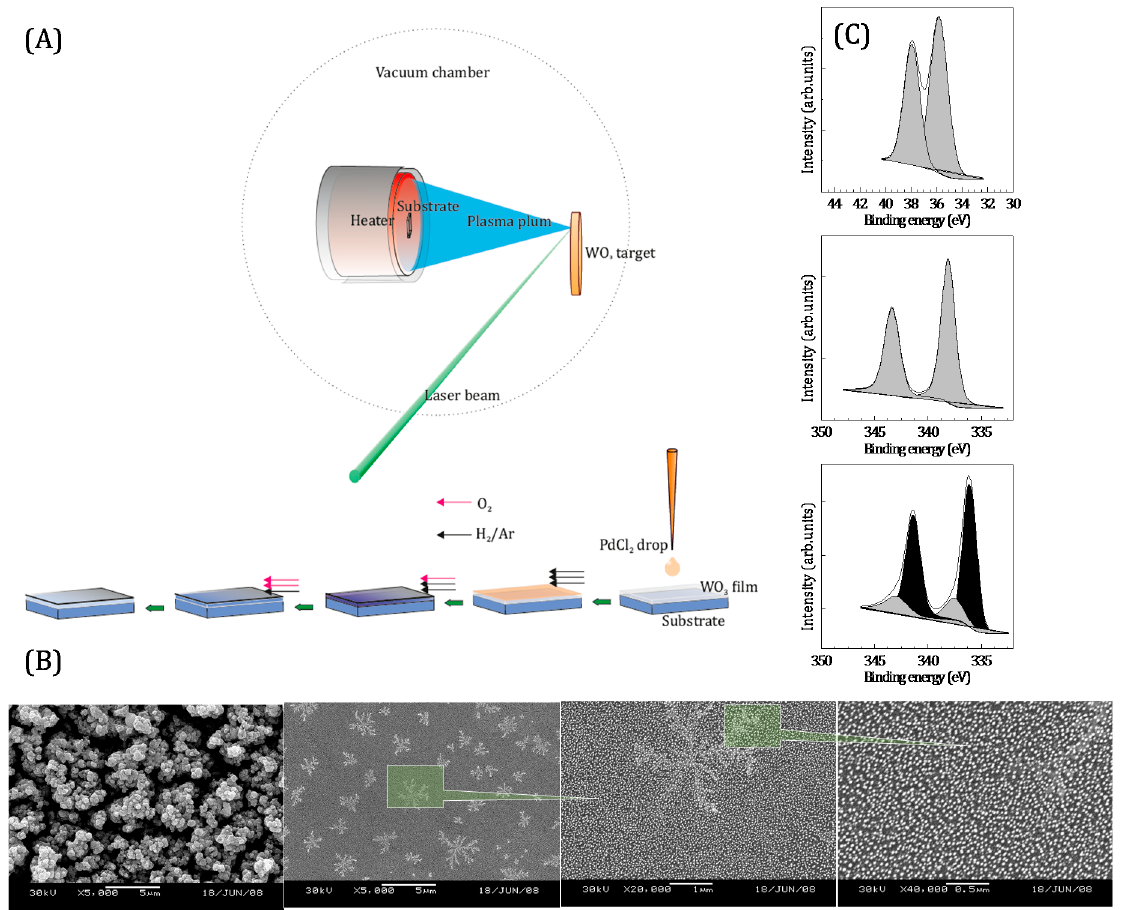
Figure 1. ( A ) Schematic representation of preparation Pd/WO 3 samples, coloration by diluted hydrogen gas and revers steps by adding oxygen flow to examine detection of oxyhydrogen gas. ( B ) typical FESEM images of WO 3 ( top-left ) and Pd/WO 3 sample and ( C ) high resolution XPS spectra of W 4f ( top ), and Pd 3d before ( middle ) and after hydrogen reduction